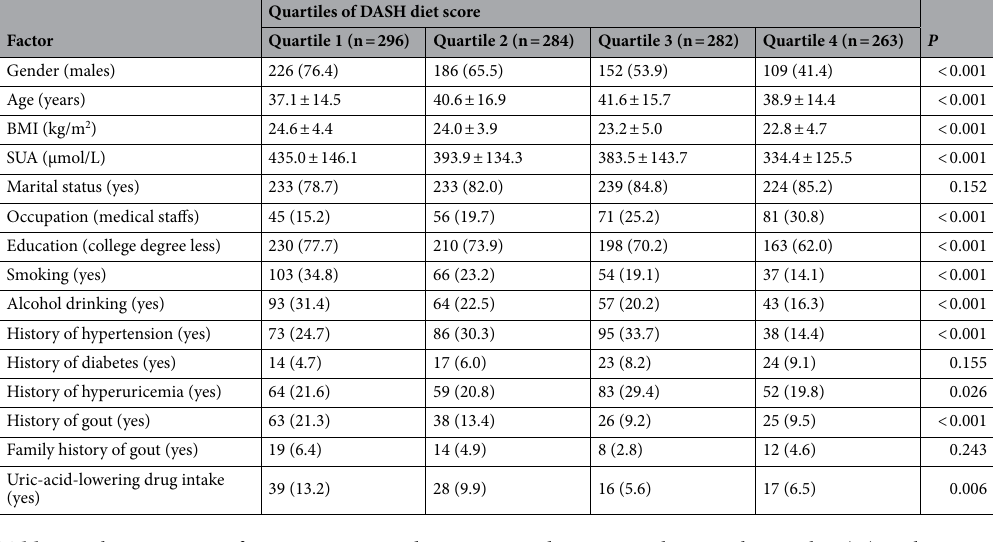
Table 2. Characteristics of participants according to DASH diet score. Values are the number (%) or the mean (± SE) unless indicated otherwise.